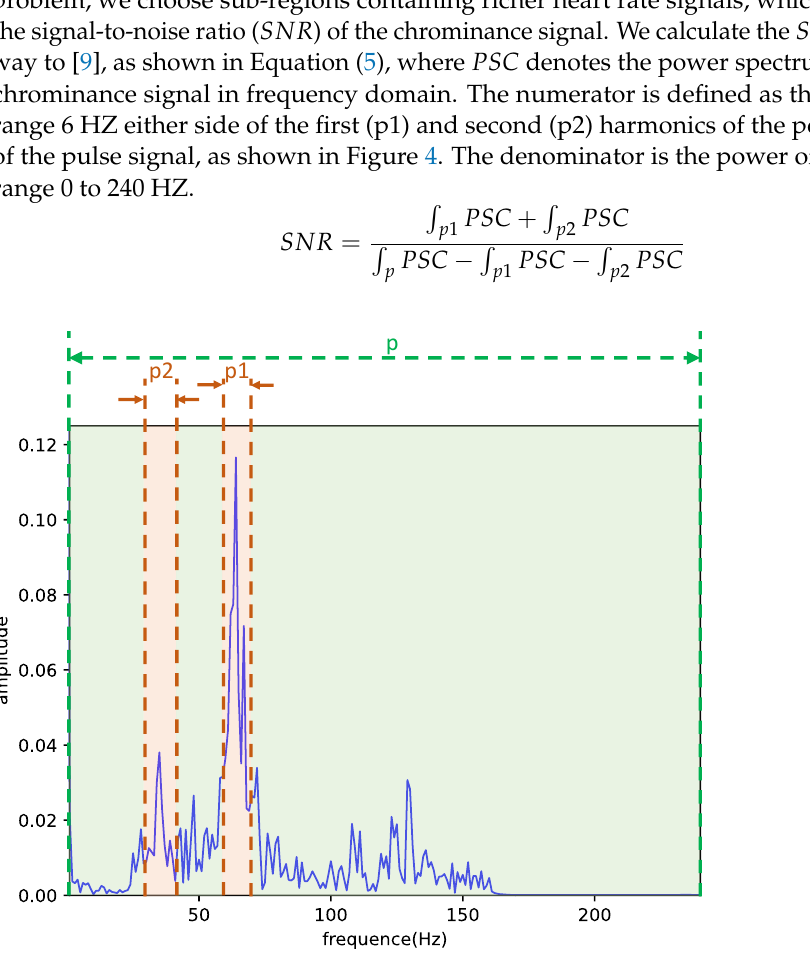
Figure 4. Calculating the SNR : the ratio of the signal power spectrum in the region surrounding maximum and second largest peak divided by the rest of signal power